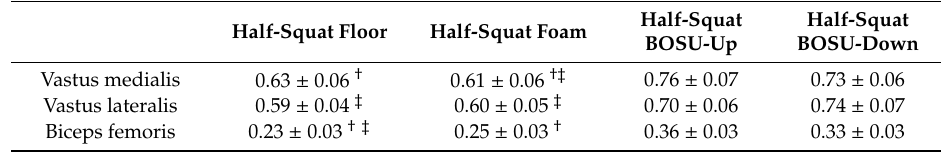
Table 4. Root mean square surface electromyography values (mV) for each muscle analysed under half-squat conditions. Values are expressed as mean ± standard error of the mean (SE)